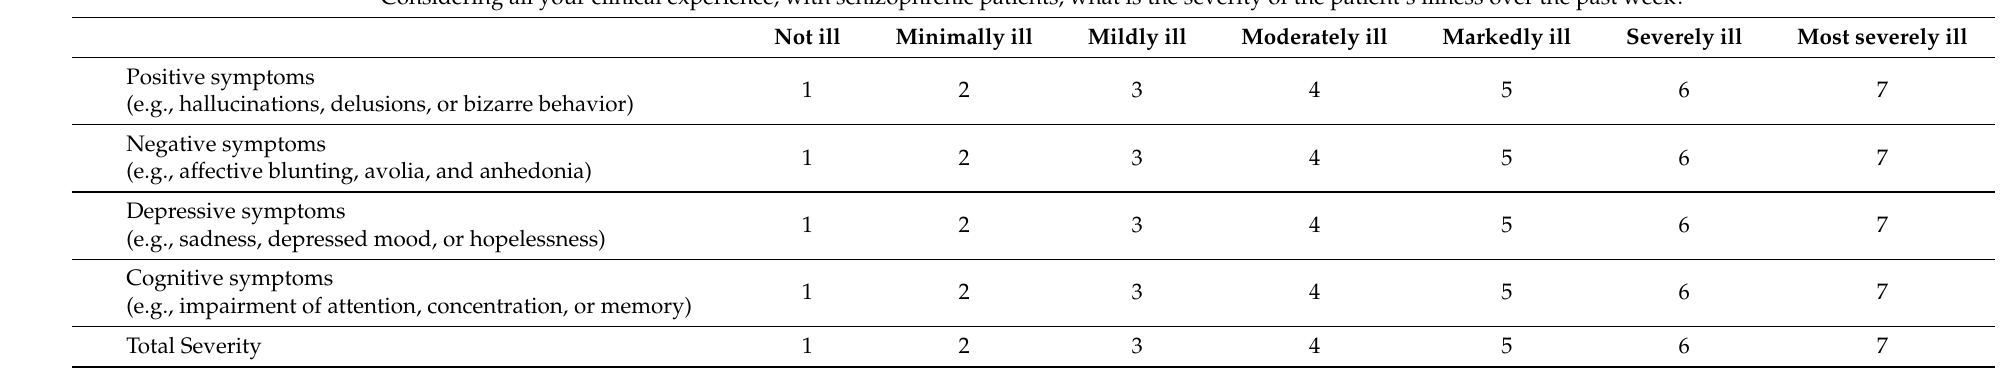
Table 1. CGI-SCH Severity of Illness: English Version